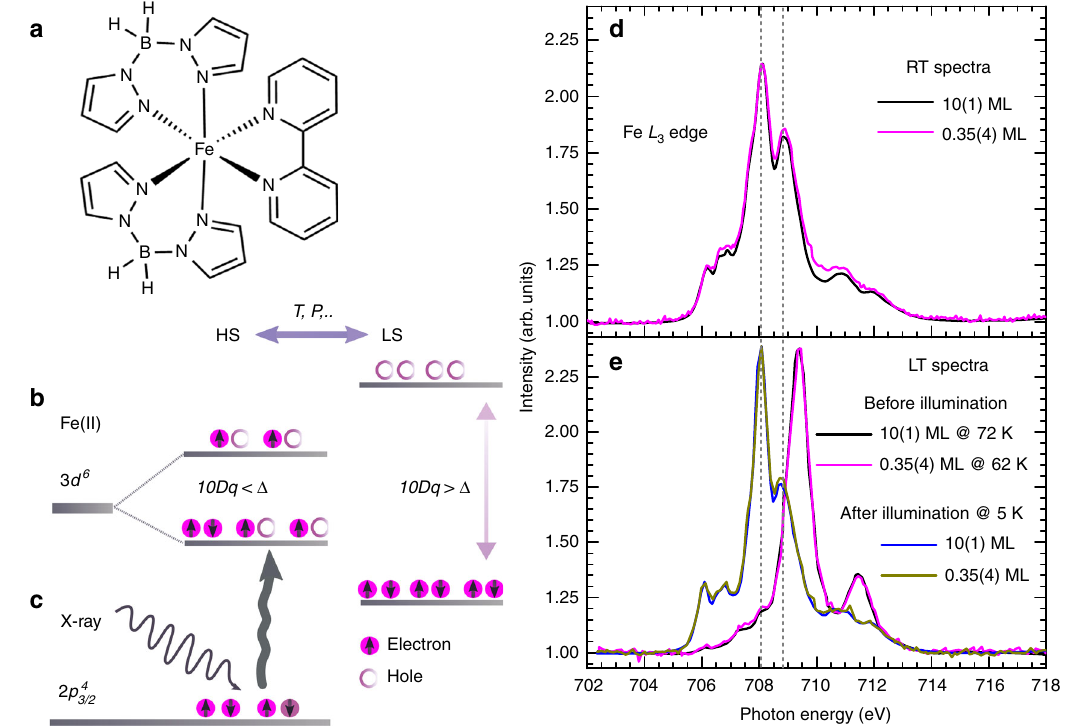
Fig. 1 High-spin and low-spin states of spin-crossover molecules as revealed by x-ray absorption spectroscopy. a Chemical structure of Fe(bpz)-bipy; b The size of the ligand fi eld splitting of the Fe 3 d 6 orbital into e g and t 2 g (10 Dq ) relative to the mean spin-pairing energy ( Δ ) leads to the HS or LS state; electrons and their excitation to the 3 d orbital (Fe L 3 edge); d RT Fe L 3 absorption spectra of 10(1) ML and 0.35(4) ML of c Interaction of x rays with 2 p 4 3 = 2 Fe(bpz)-bipy on HOPG (black and magenta lines, respectively), and e at 72 K and 62 K before illumination (black and magenta lines, respectively), and after illumination with a green LED (blue and dark-yellow lines, respectively) at 5 K. The absorption intensities of the 0.35(4)-ML sample have been scaled to that of the 10(1)-ML